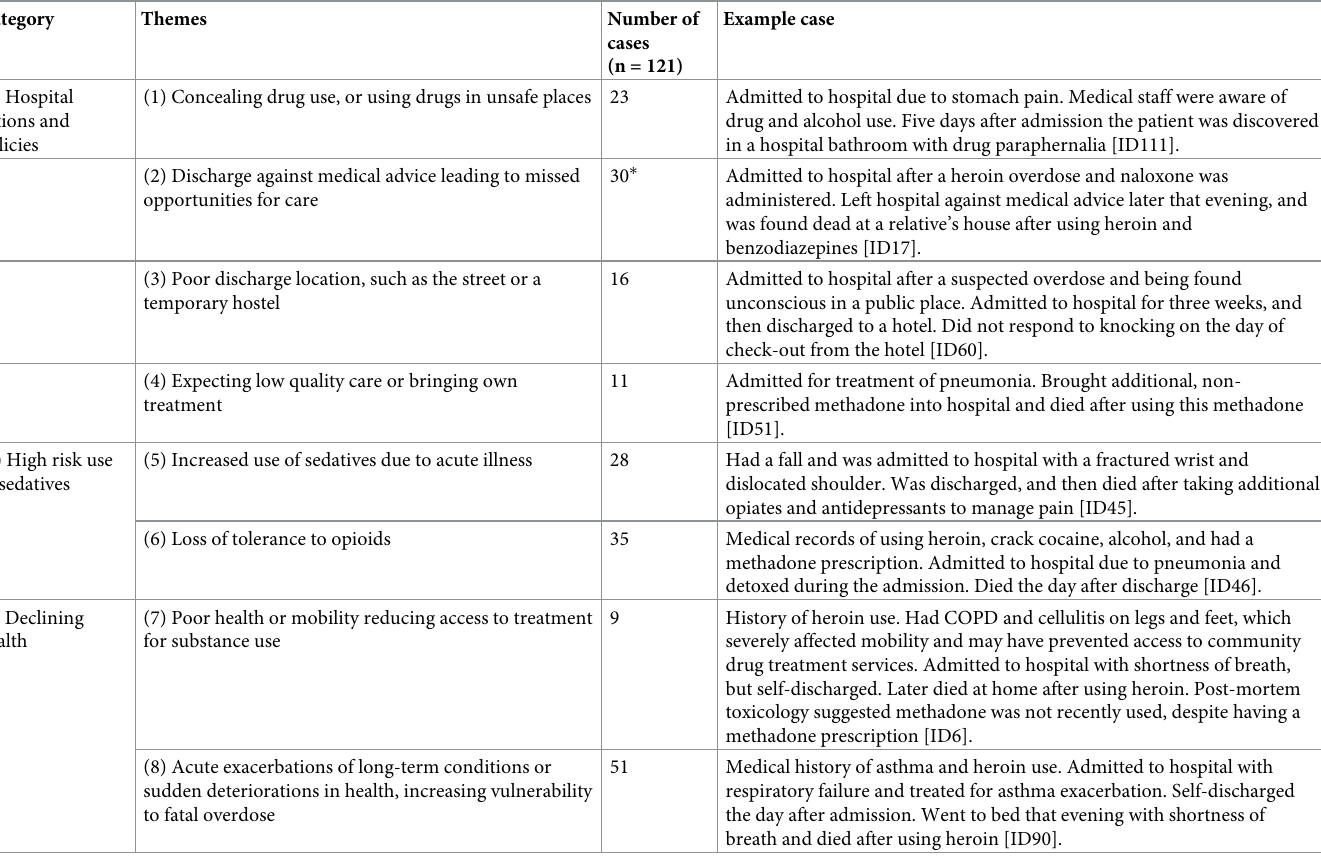
Table 2. Themes relating to the risk of opioid-related deaths during hospital admissions or shortly after hospital